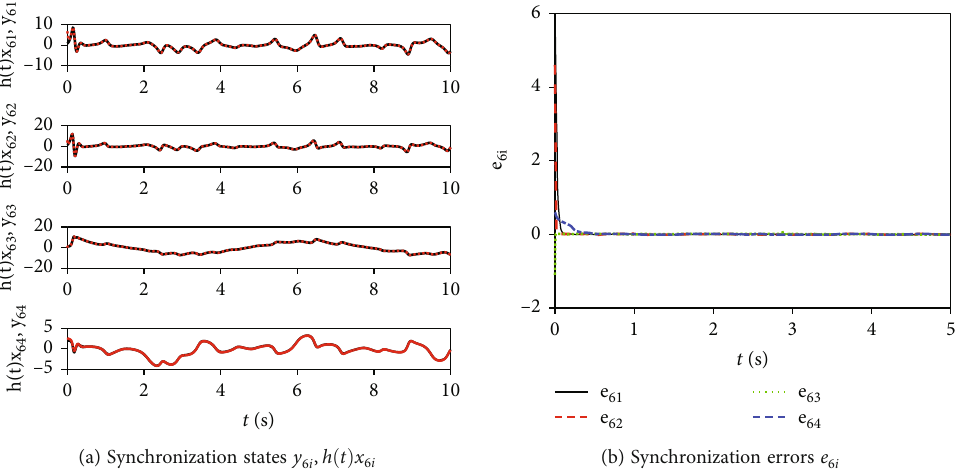
Figure 13: The time evolution of synchronization between y